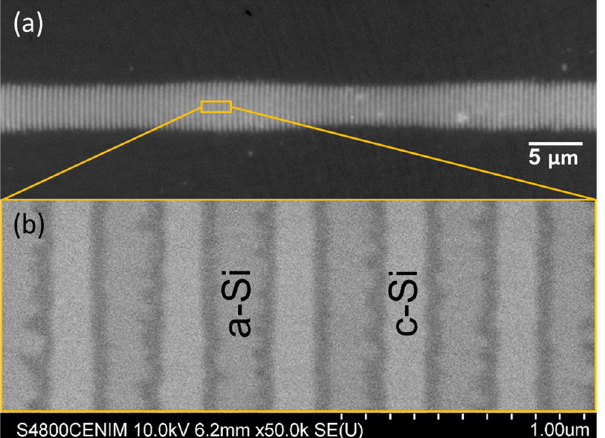
Figure 8. Line of short-period amorphous fringes ( Λ s − LIPSS) written at F = 180 mJ / cm 2 and 320 µ m / s .